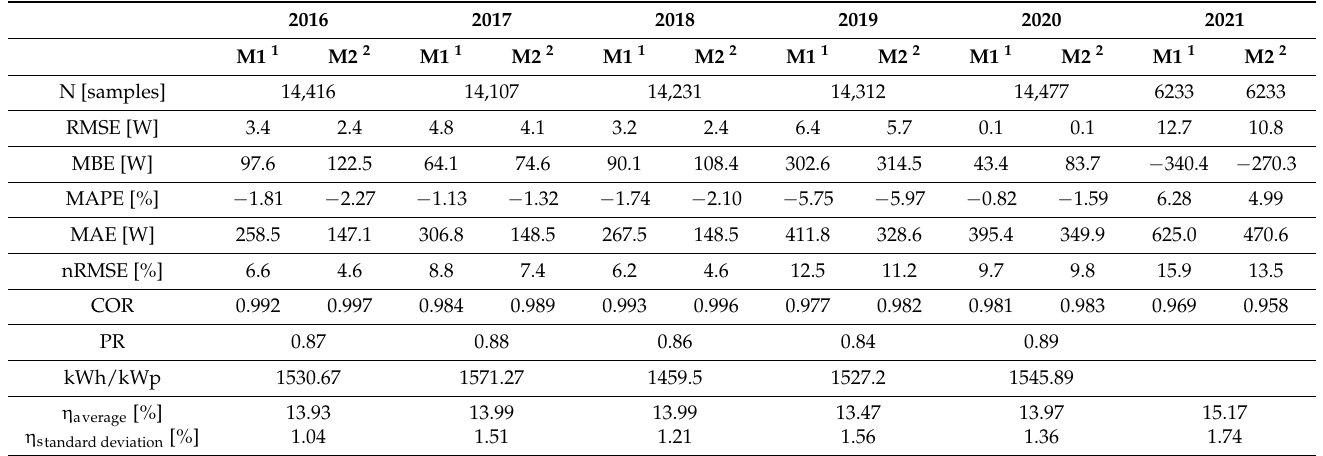
Figure 16. Comparison of the evolution of measured irradiance for six consecutive days of April between 2013 and 2021. Table 2. Statistical and energy metrics for 2016–2021 (M1 and M2